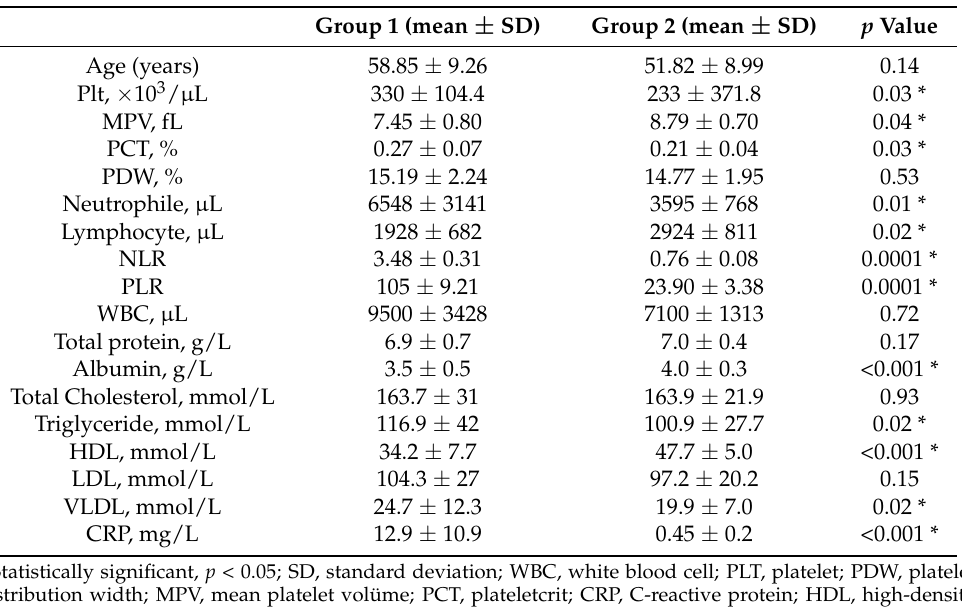
Table 1. Laboratory findings of lung cancer patients (Group 1) and control cases (Group 2).